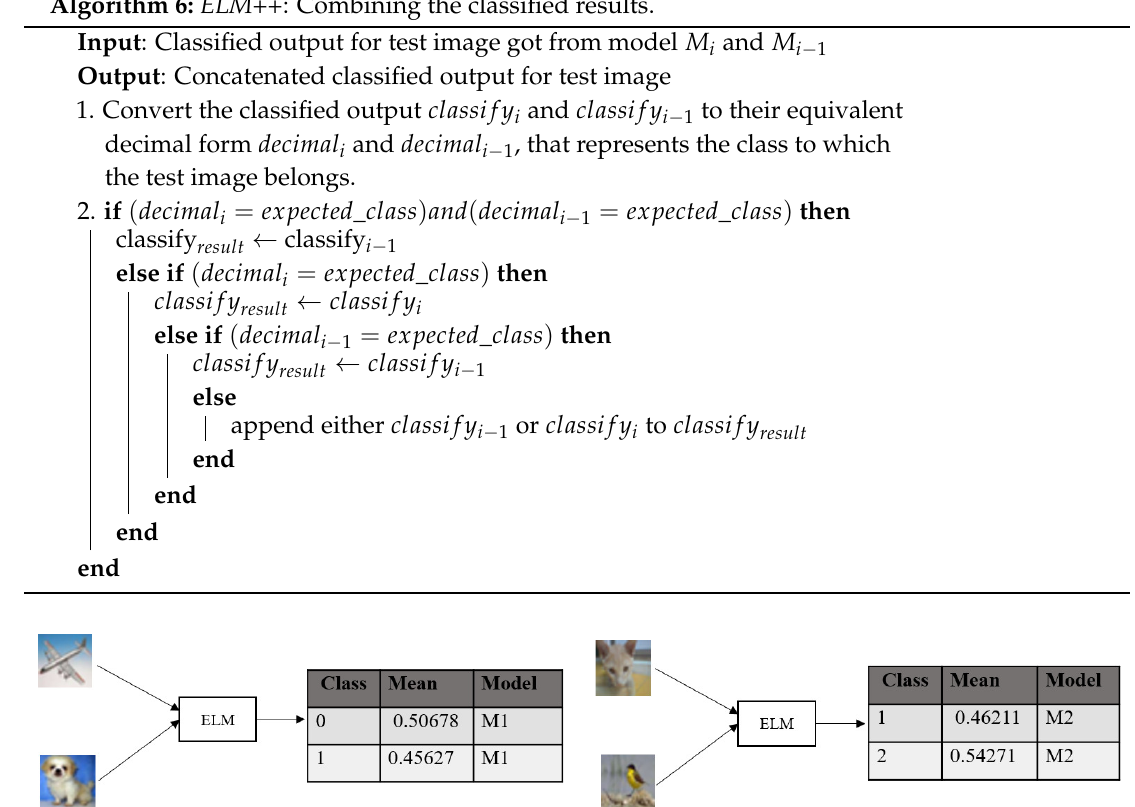
Algorithm 6: ELM++ : Combining the classified results.